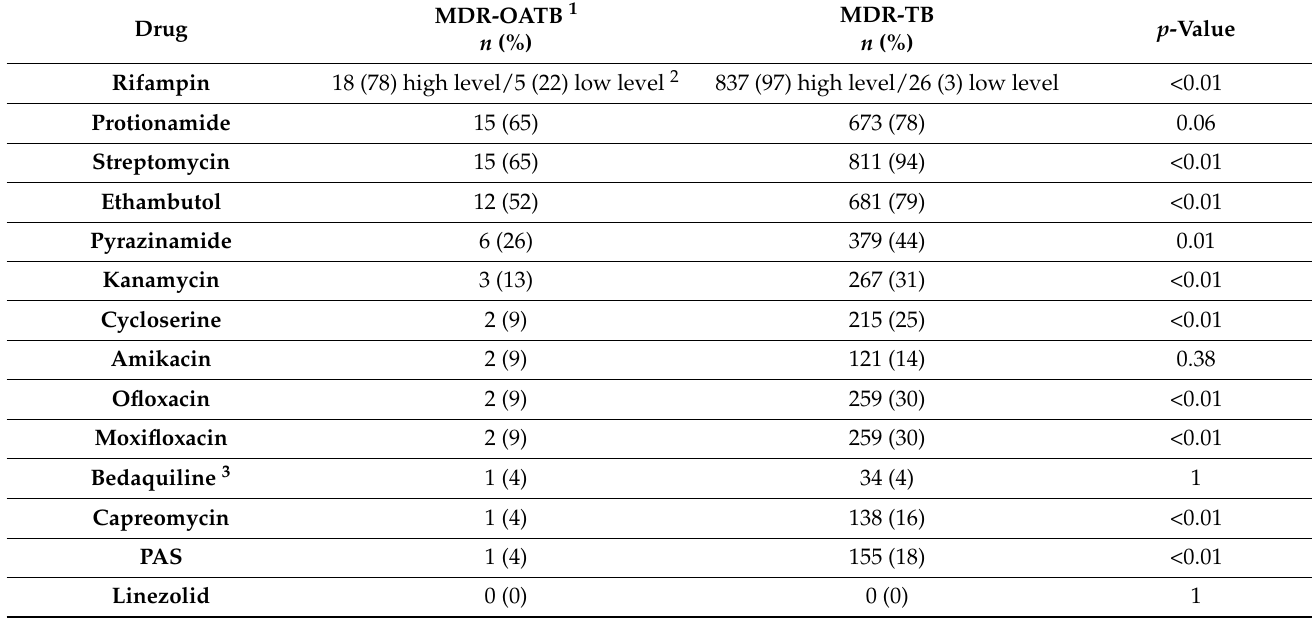
Table 3. Resistance to anti-TB drugs (%) among strains isolated from patients with multidrug-resistant osteoarticular TB in France ( n = 23) and among all strains isolated from MDR-TB patients ( n = 863), from 2007 to